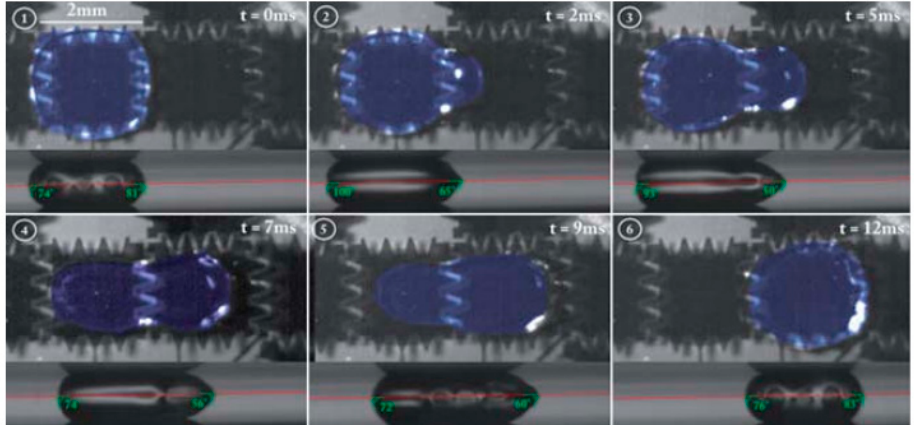
Figure 10. Both top and side views of water droplet transport on the superhydrophobic surface at different times. Reproduced with permission from [133], published by Royal Society of Chemistry, 2011.